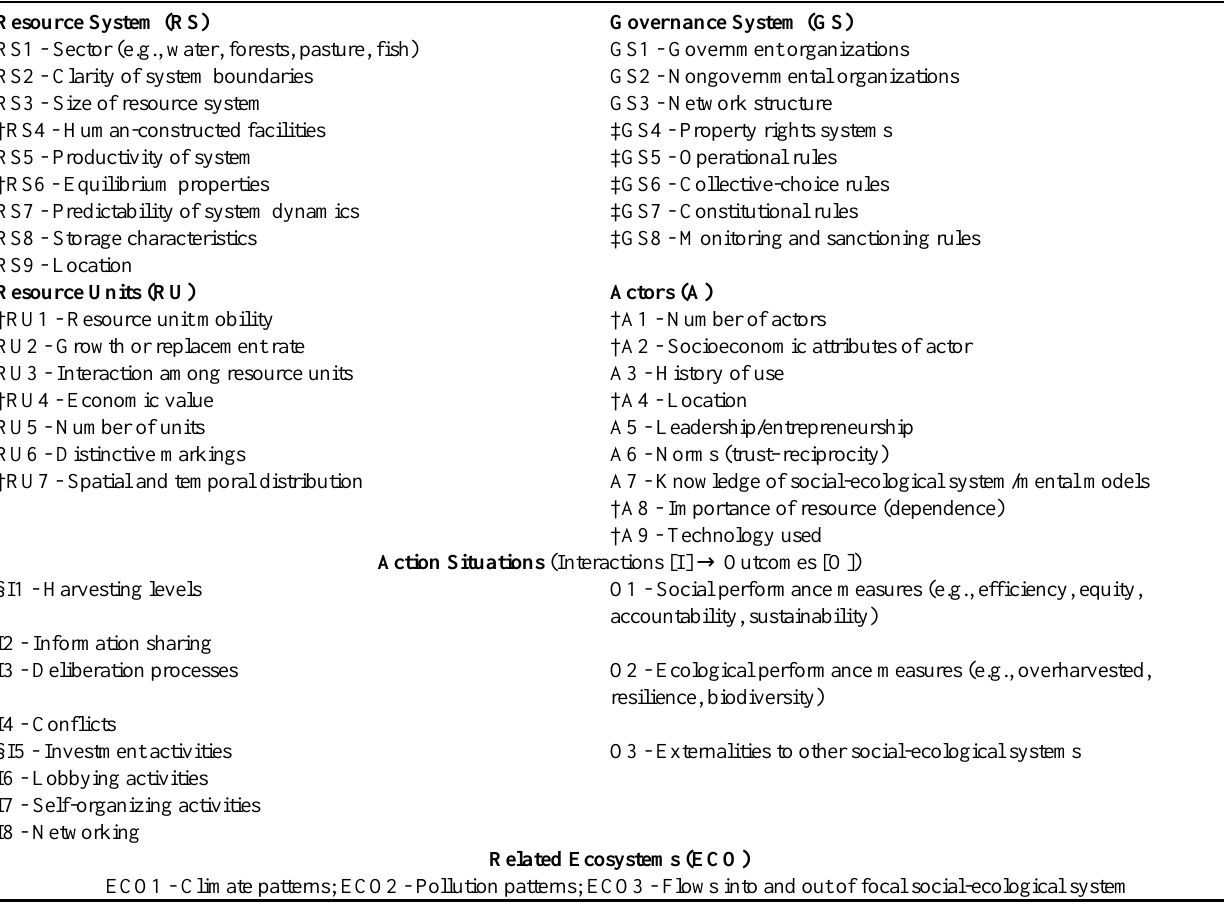
Table 1 . Variables of the social-ecological system in Grindelwald affected by societal transitions. Based on Ostrom (2007, 2009), and M. McGinnis and E. Ostrom ( unpublished manuscript ). Social, Economic, and Political Settings